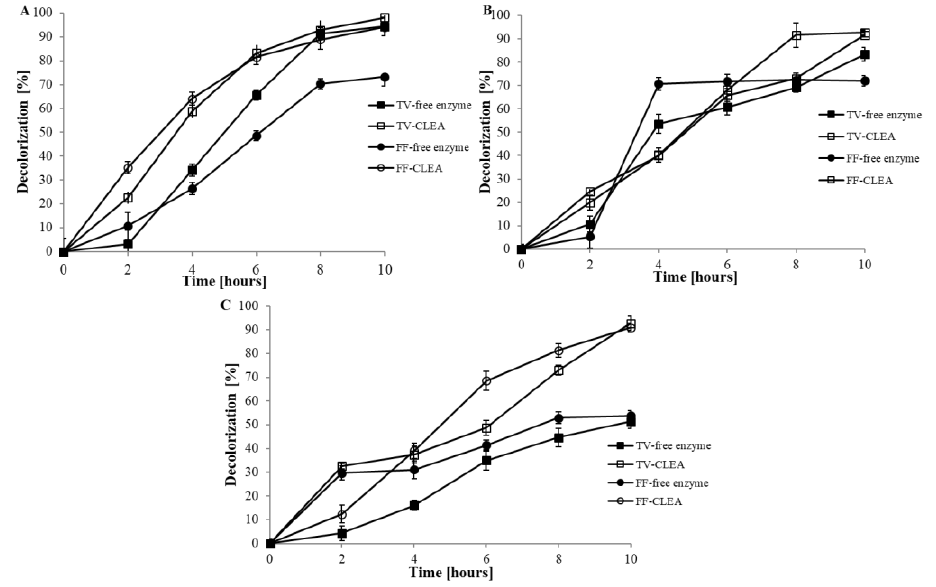
Figure 4. Experiment of decolourisation ability of CLEA and free laccases from T. versicolor and F. fomentarius for ( A ) Malachite Green; ( B ) Bromothymol Blue, and ( C ) Methyl Red.